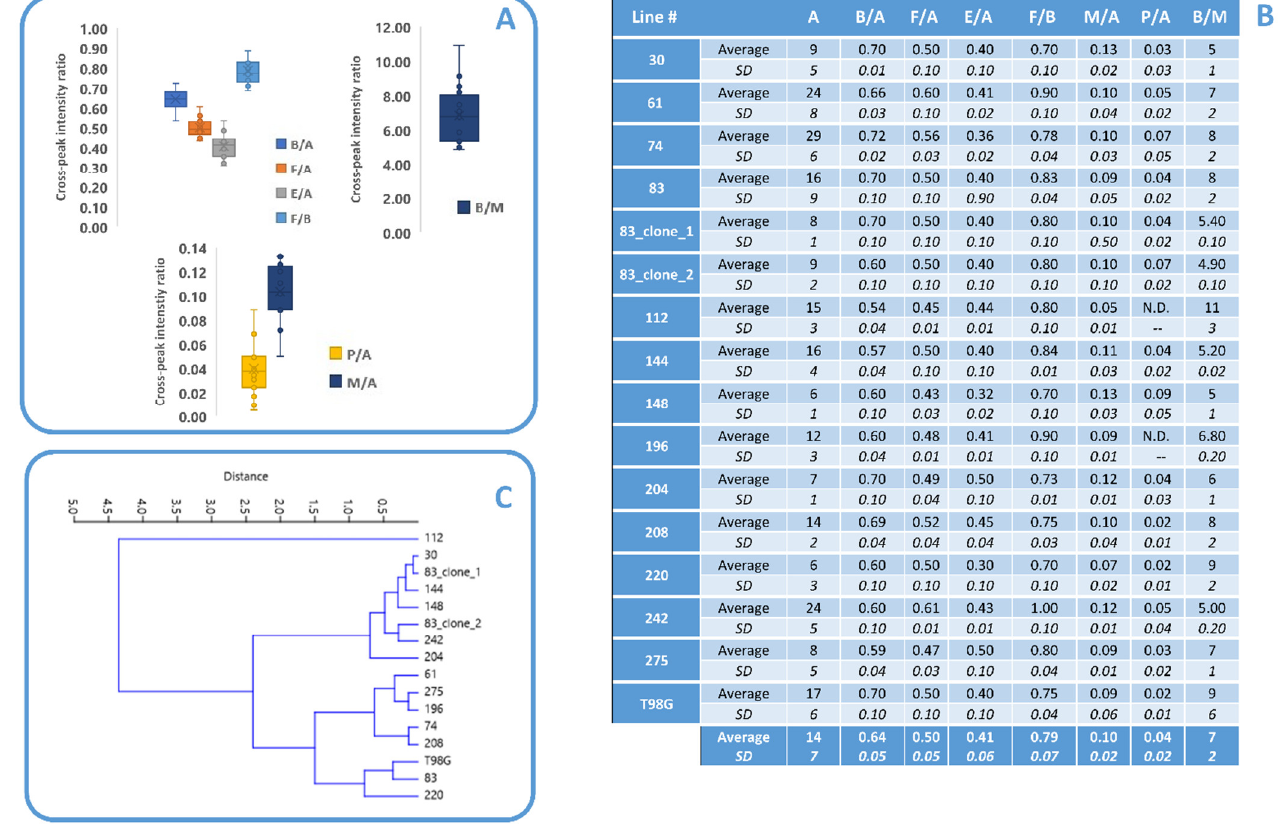
Figure 3. ( A ) Box and Whisker Plot comparing the cross-peak ratios B/A, F/A, E/A, F/B, B/M, M/A, and P/A from all MES cell line spectra. ( B ) Average values and standard deviations of the aforementioned ratios and of cross peak A for each MES cell line, for the subclones, and T98G, and for all analyzed ones calculated in at least three independent experiments. Average and standard deviation inter lines for each parameter is also reported. ( C ) Dendrogram resulting from unsupervised cluster analysis of values of eight metabolic parameters related to lipid unsaturation from MR spectra from all cell lines (B/A, F/A, E/A, M/A, P/A, (M+P)/A, F/B, B/M). All these MES cell lines are grouped into a single cluster with the only exception of GSC line #112. N.D. stands for undetectable.